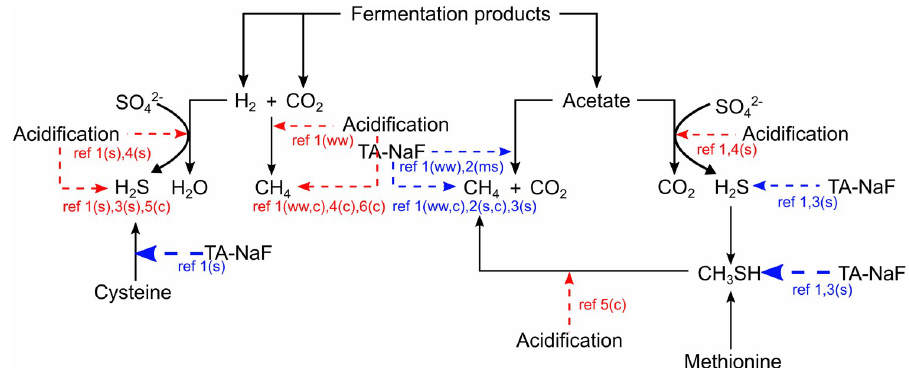
Fig 8. Inhibition (dashed arrows) of sulfur transformations and methanogenesis by TA-NaF (tannic acid with sodium fluoride) or acidification treatment of swine manure and other inocula. Blue arrows and text indicate inhibition effect seen for TA-NaF treatment. Red arrows and text indicate inhibition effect seen for acidification treatment. Thicker arrows indicate stronger inhibition than thin arrows of the same color. When inhibition arrows point at compounds, it indicates that emission of that compound was reduced but the inhibited pathway was not identified. Ref 1 is this study, ref 2 is Dalby et al. 2020, Bioresour. Technol, ref 3 is Dalby et al. 2020, Environ. Sci. Technol., ref 4 is Ottosen et al. 2009, ref 5 is Eriksen et al. 2012, ref 6 is Petersen et al. 2012. For the references, (s) indicates swine manure was used, (c) indicates cattle manure, (ww) indicates wasterwater sludge, and (ms) indicates maize